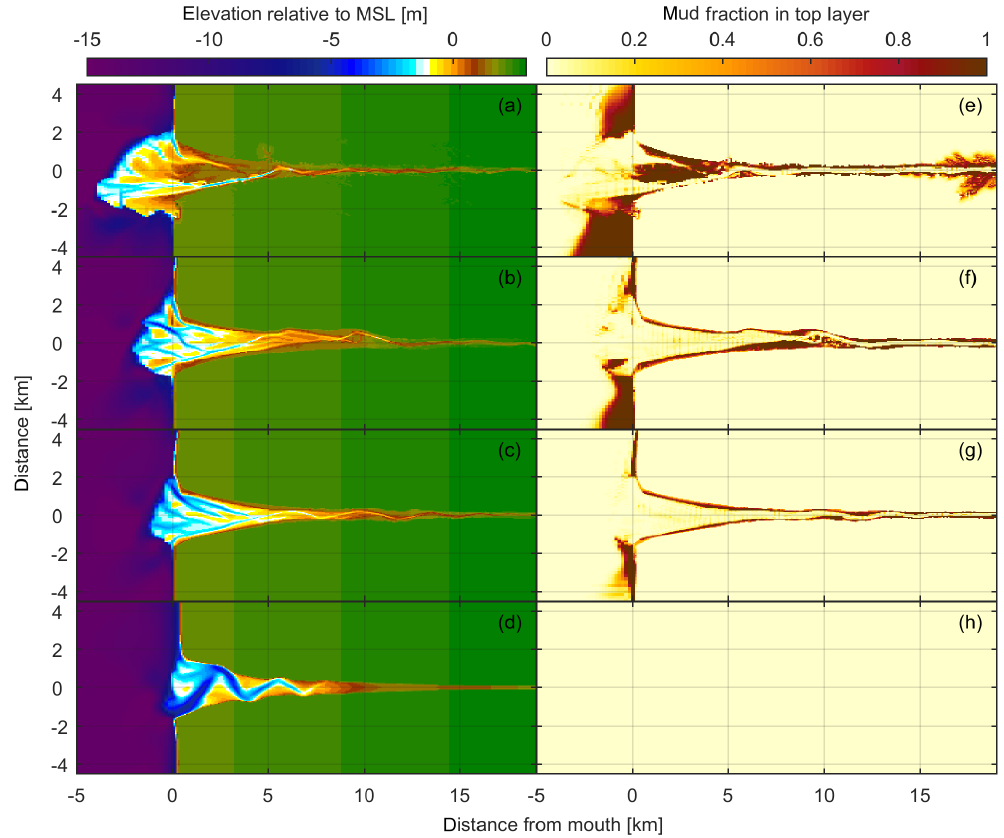
Figure A4. Effects of river discharge (runs 08, 01, 07 and 22). The left column shows the final bathymetry of model runs after 2000 years and the right column shows mud fractions in the top layer of the bed. Run with (a, e) 150, (b, f) 100 (default), (c, g) 50 and (d, h) 0m 3 s − 1 river